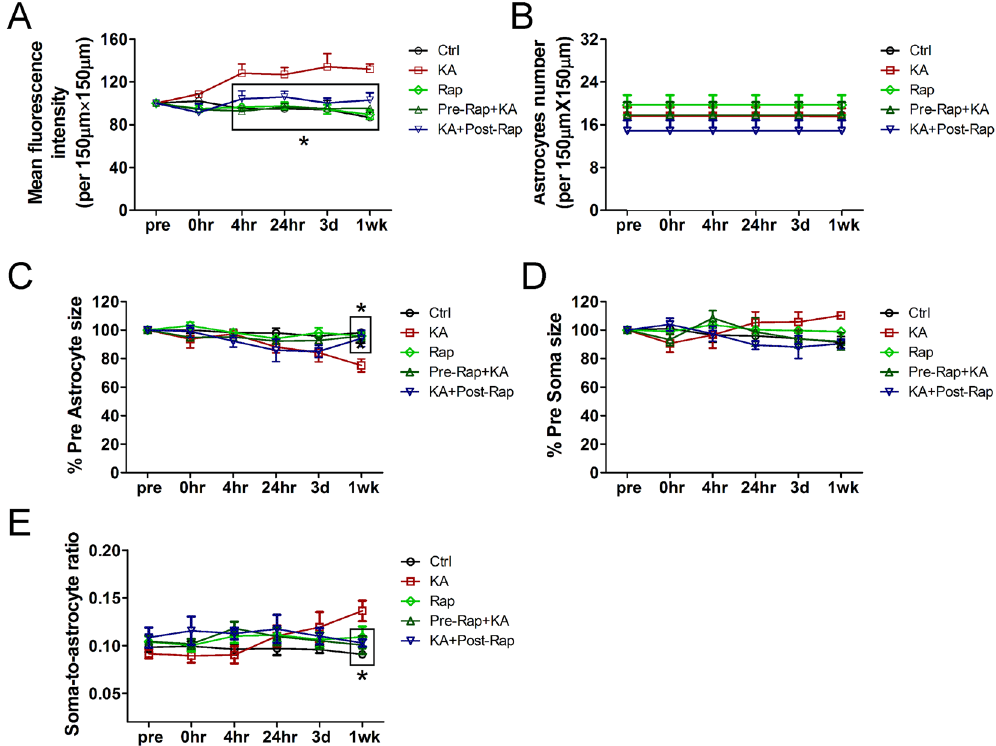
Figure 7. Quantitative analysis of effect of rapamycin treatment on KA seizures induced fluorescence intensity, astrocyte number and morphological changes (astrocyte size, soma size and soma-to-astrocyte ratio) over a one-week period. ( A ) Changes in mean fluorescence intensity over a one-week period in Ctrl, Rap, KA, Pre-Rap + KA, and KA + Post-Rap groups. Starting from 4 hr after KA seizures, mean fluoroscence intensity increased significantly in KA group when compared to Ctrl, Rap, Pre-Rap + KA, and KA + Post-Rap groups. Both rapamycin pre- and post- treatment reversed the increase in fluorescence intensity. ( * p < 0.05 compared with KA at 4 hr, 24 hr, 3 d and 1 wk, by repeated measures two-way ANOVA with Bonferroni posttests). ( B ) Changes of astrocyte number over a one-week period in Ctrl, Rap, KA, Pre-Rap + KA, and KA + Post-Rap groups. There is no significant difference among the five groups in astrocytes number at all observed time- points (p > 0.05, by repeated measures two-way ANOVA with Bonferroni post-test). ( C ) Changes of astrocyte size during a one-week period in Ctrl, Rap, KA, Pre-Rap + KA, and KA + Post-Rap groups. Compared to Ctrl, Rap, Pre-Rap + KA, and KA + Post-Rap groups, astrocyte size decreased significantly at 1 wk after seizures in KA group. Both rapamycin pre- and post- treatment reversed the decrease of astrocyte size at 1 wk after seizures ( * p < 0.05 compared with KA at 1 wk, by repeated measures two-way ANOVA with Bonferroni post-test). ( D ) Changes of soma size over a one-week period in Ctrl, Rap, KA, Pre-Rap + KA, and KA + Post-Rap groups. There is no significant difference among five groups in soma size at all observed time-points (p > 0.05, by repeated measures two-way ANOVA with Bonferroni post-test). ( E ) Changes of the ratio of soma-to-astrocyte during a one-week period in Ctrl, Rap, KA, Pre-Rap + KA, and KA + Post-Rap groups. The ratio decreased significantly in KA group when compared to Ctrl, Rap, Pre-Rap + KA, and KA + Post-Rap groups at 1 wk after seizures. Both rapamycin pre- and post-treatment reversed the ratio of soma-to-astrocyte at 1 wk after seizures ( * p < 0.05 compared to KA at 1 wk by repeated measures two-way ANOVA with Bonferroni